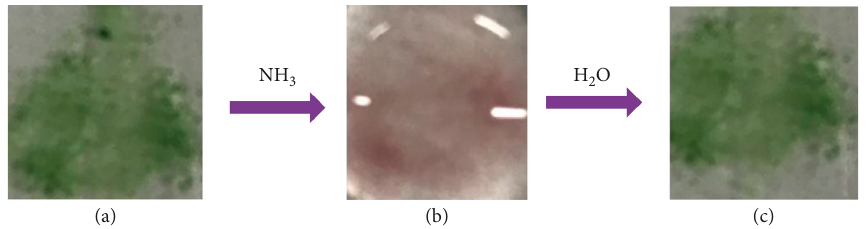
Figure 8: Changes in ZnTPP in each cycle: (a) original state, (b) after reaction with NH